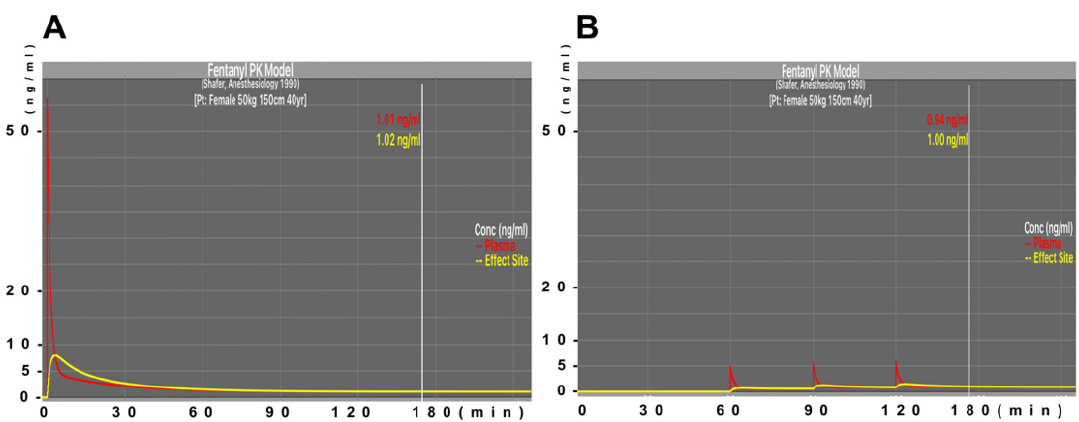
Figure 1. Estimated concentrations of fentanyl during operation. The effect site concentration (yellow line) and plasma concentration (red line) of fentanyl were estimated by pharmacokinetic simulation using the Shafer model (AnestAssist, Palma Healthcare Systems, Madison, WI, USA). The model female patient was assumed to be 40 years old, weighed 50 kg, and was 150 cm tall. Panel ( A , B ) represent the concentrations in the group A and B protocols.